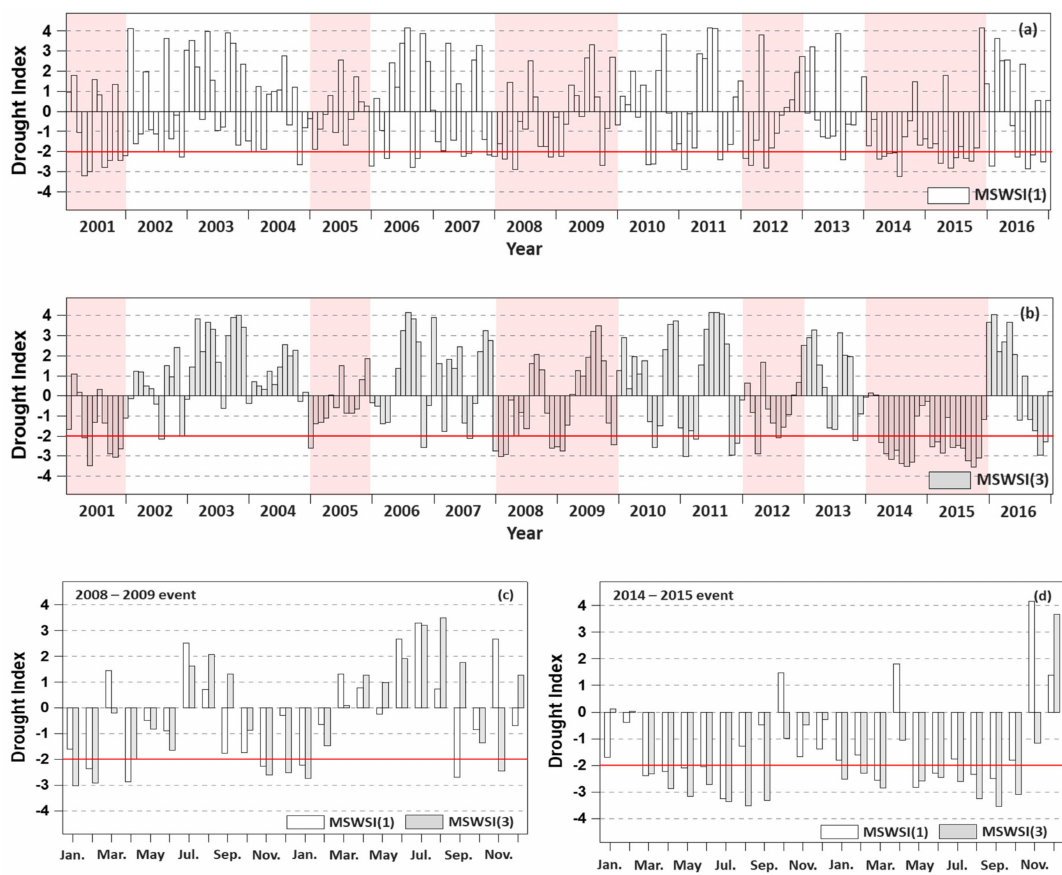
Figure 3. MSWSI results for 1-month and 3-month data periods; ( a ) time-series of MSWSI(1) during